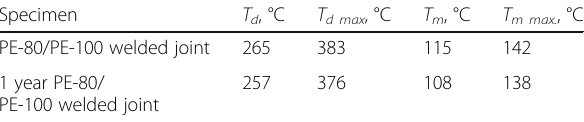
Table 2 Thermal characteristics of the PE-80/PE-100 welded joint Specimen